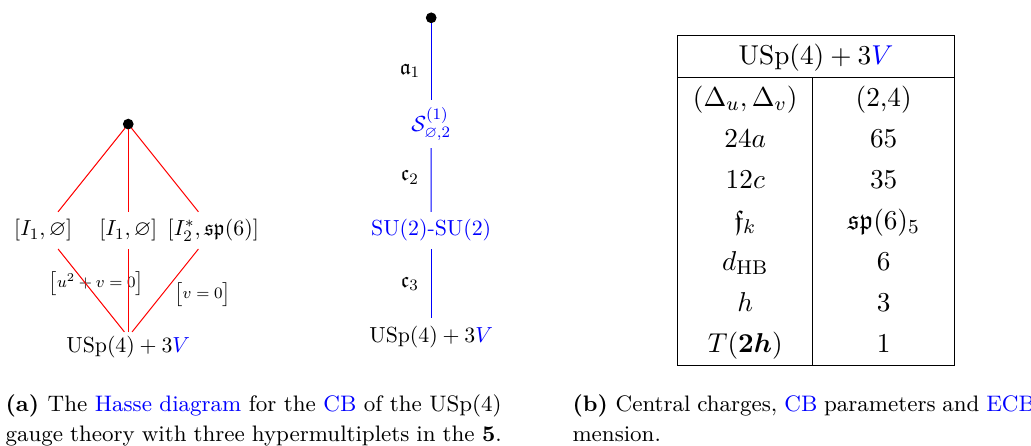
Figure 32. Information about the USp(4) N = 2 theory with three hypermultiplet in the 5 .